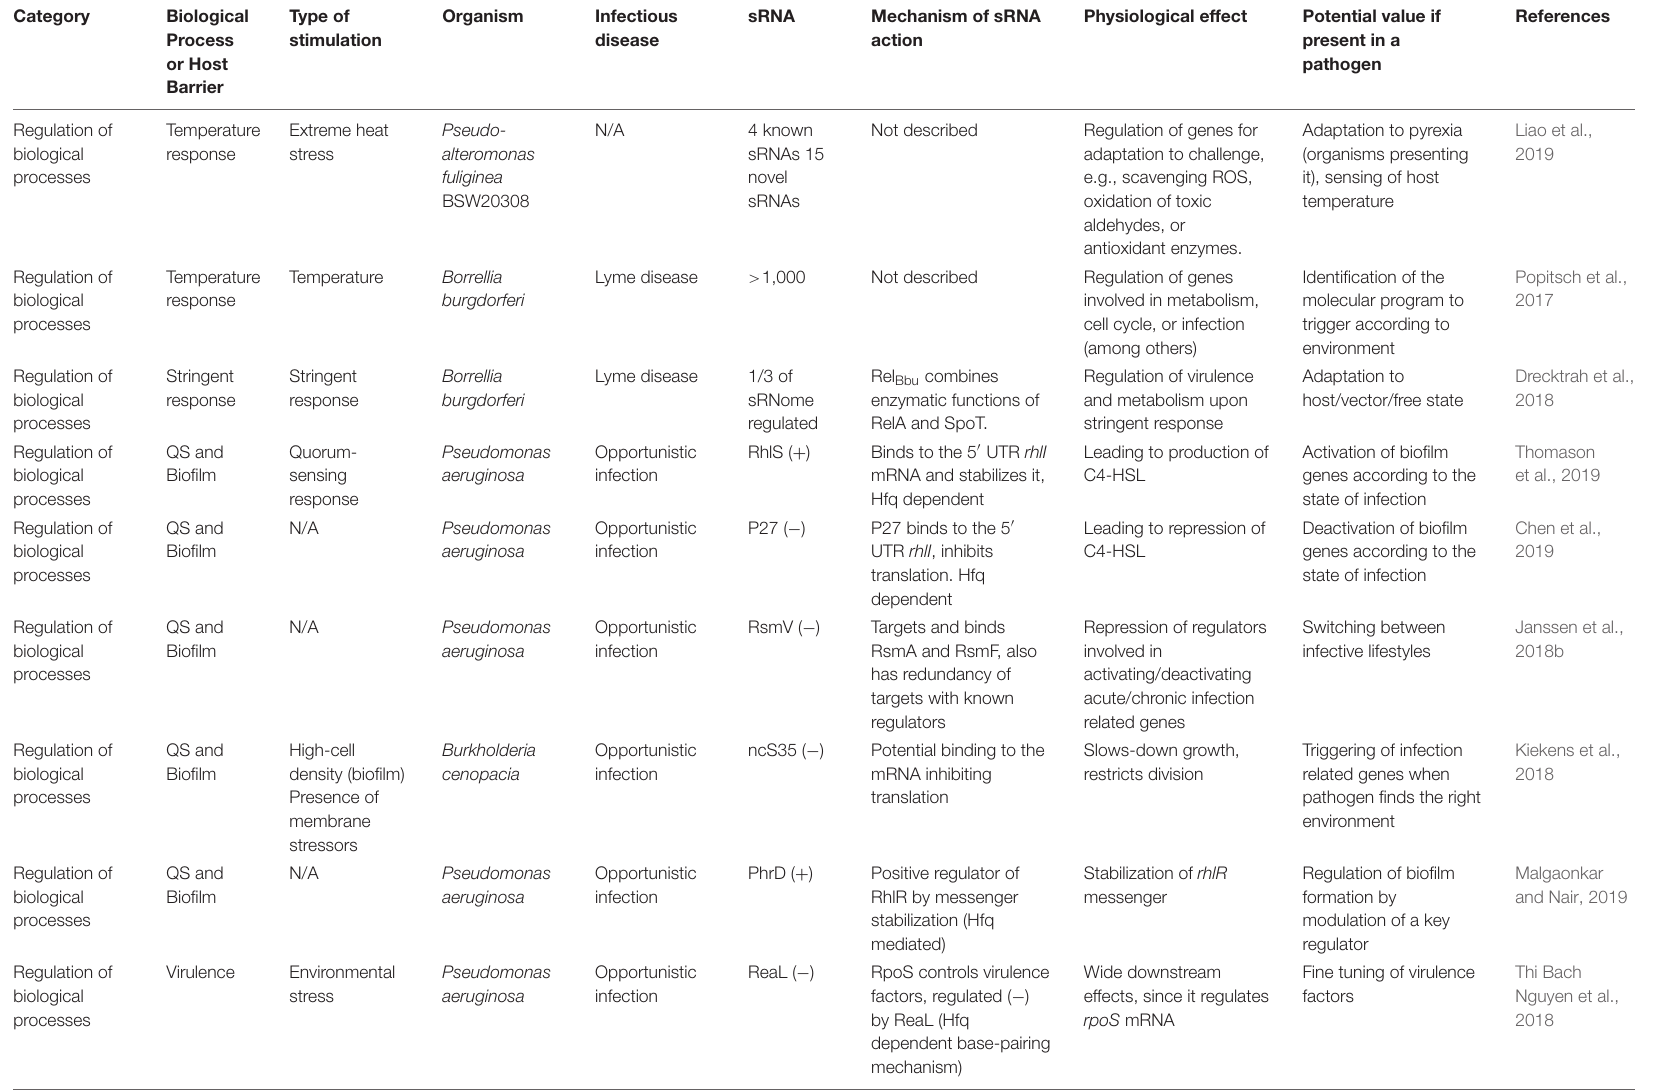
TABLE 1 | Adaptation to environmental stresses mediated by